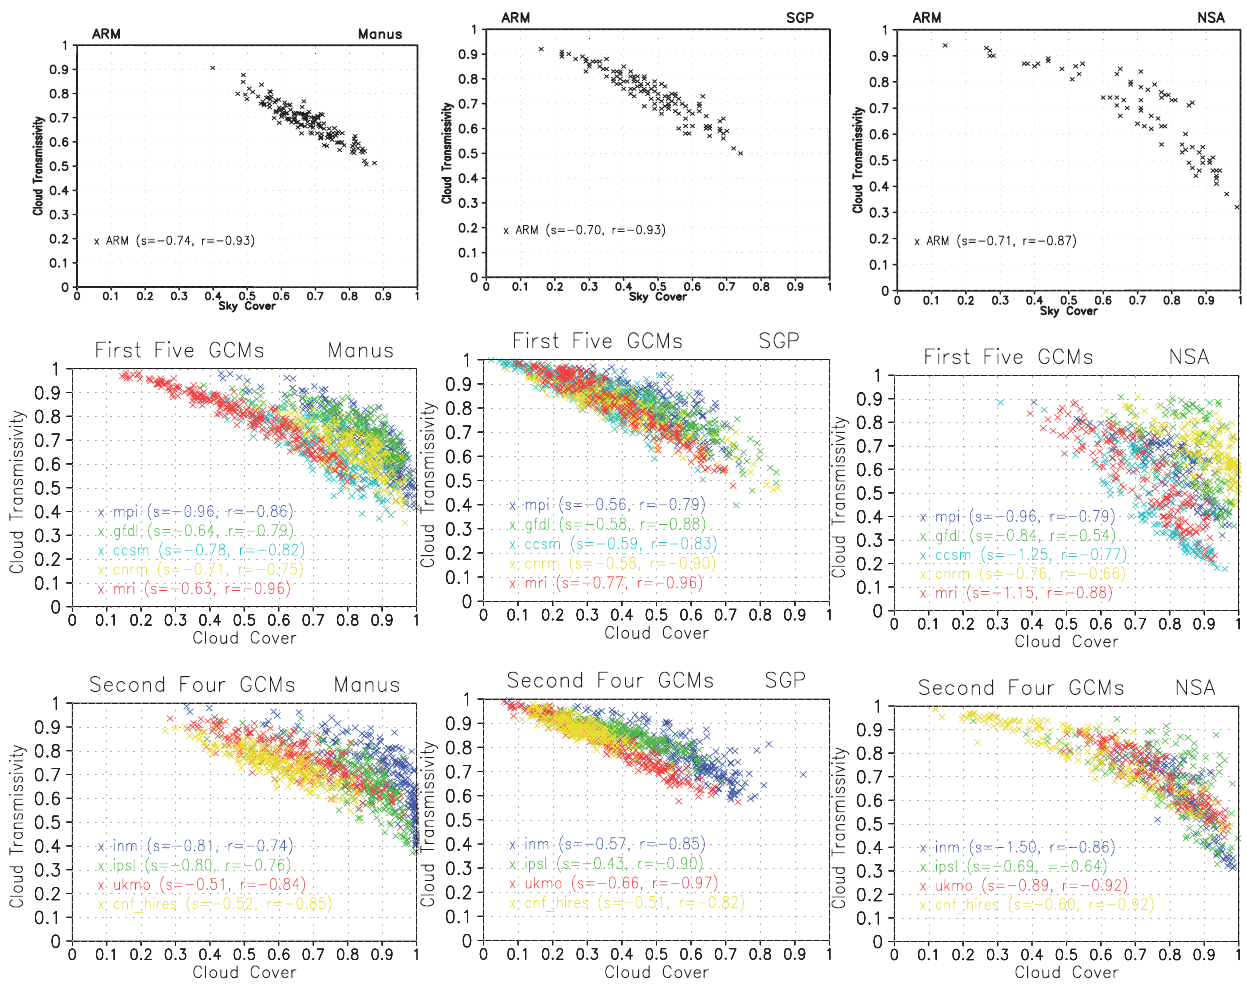
Fig. 8. The monthly mean SW transmissivity (Tsw) against their corresponding TCF for both observation and nine GCMs over three ARM sites. (a) Manus (left), (b) SGP (middle), and (c) NSA